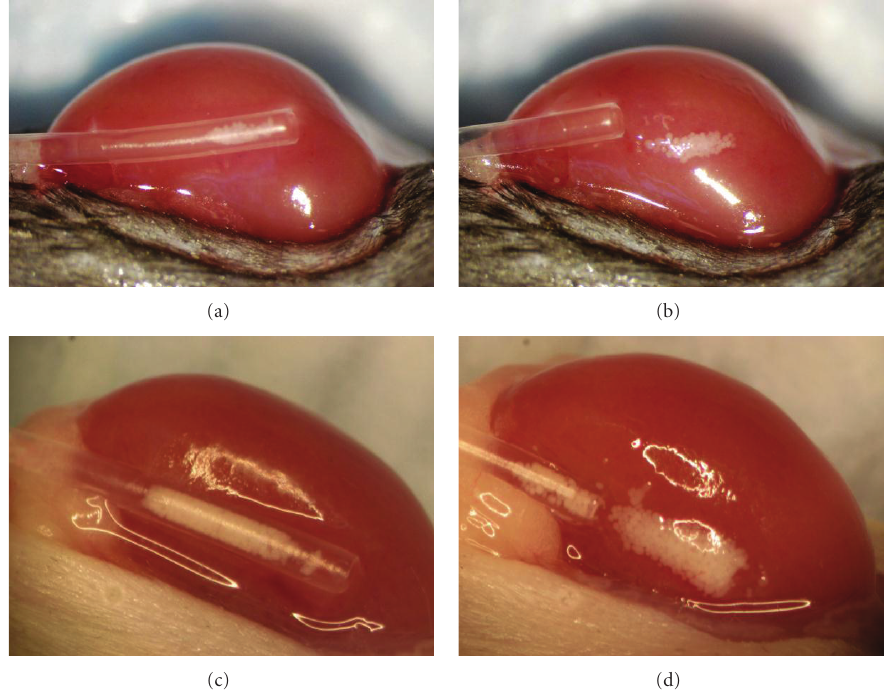
Figure 6: Islet transplantation under the kidney capsule. (a) Mouse kidney with PE50 tubing containing 70 syngeneic islets in HBSS-BSA solution. (b) Islets are expelled from the tubing and deposited under the capsule with no islets remaining adherent inside the tubing. (c) For comparison, islet transplant using 400 islets frequently required for grafts transplanted without BSA to achieve normalization. (d) Some islets adhere to the tubing after depositing the majority under the kidney capsule. Original magnification 65x.